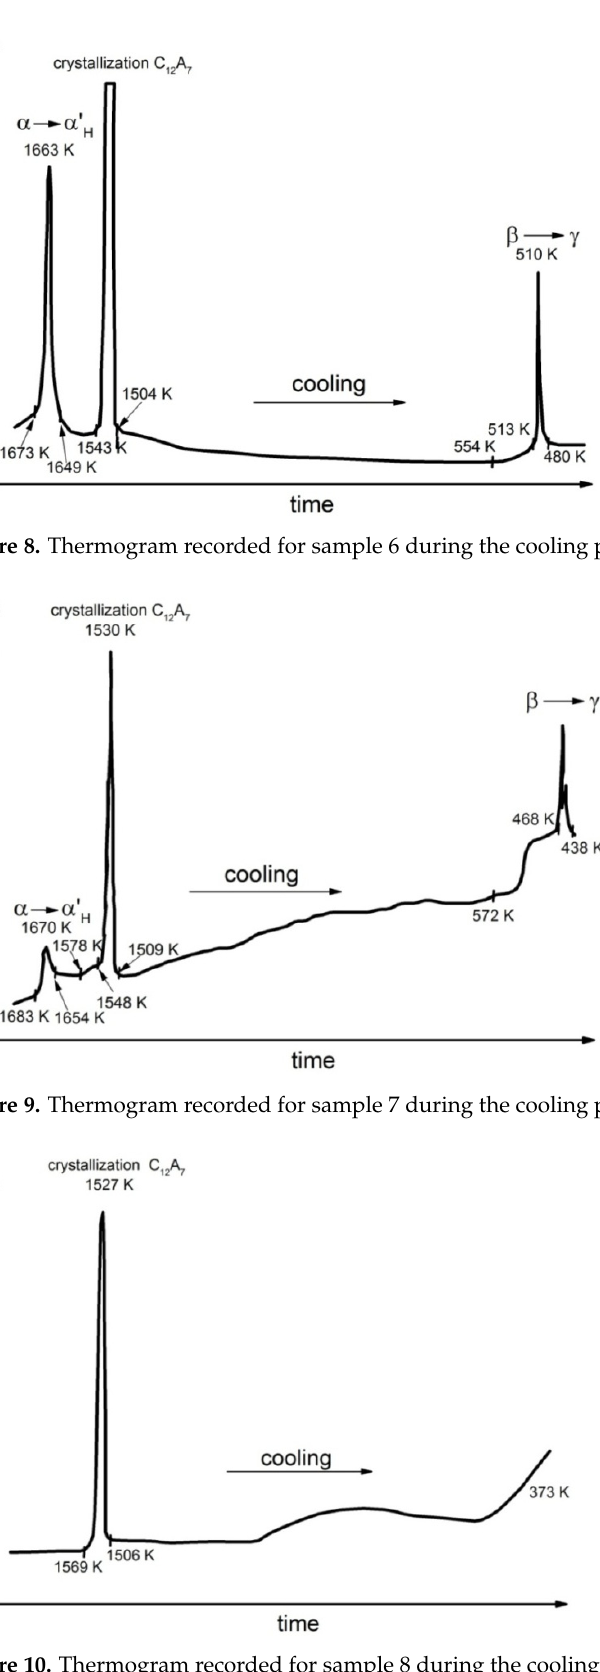
Figure 10. Thermogram recorded for sample 8 during the cooling process.